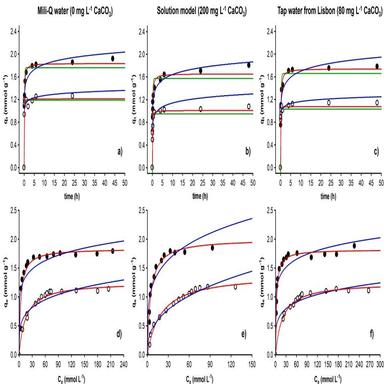
Approximation of experimental data to: (a-c) kinetic models to describe the adsorption of Atenolol in different water matrices, tested models: pseudo first order (green), pseudo second order (red), Elovich (blue); (d-e) equilibrium models to describe the adsorption of Atenolol in different water matrices, tested models: Langmuir (red) and Freundlich (blue). Adsorbents: ● BioC and ○ C-Com. (For interpretation of the references to colour in this figure legend, the reader is referred to the web version of this